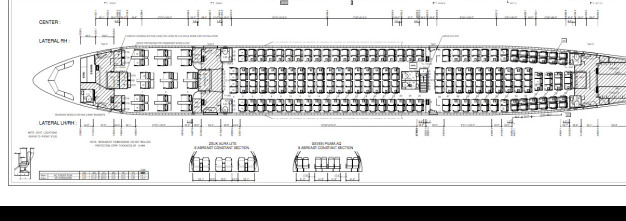
Anatomy of airbus.